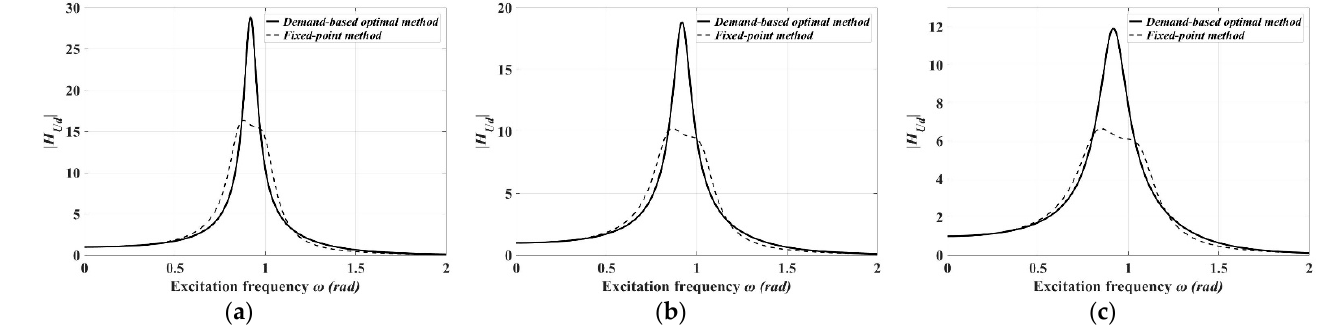
Figure 17. Transfer function of deformation of damping element of CIVD in SC system: ( a ) γ Ur = 0.7; ( b ) γ Ur = 0.6; and ( c ) γ Ur =